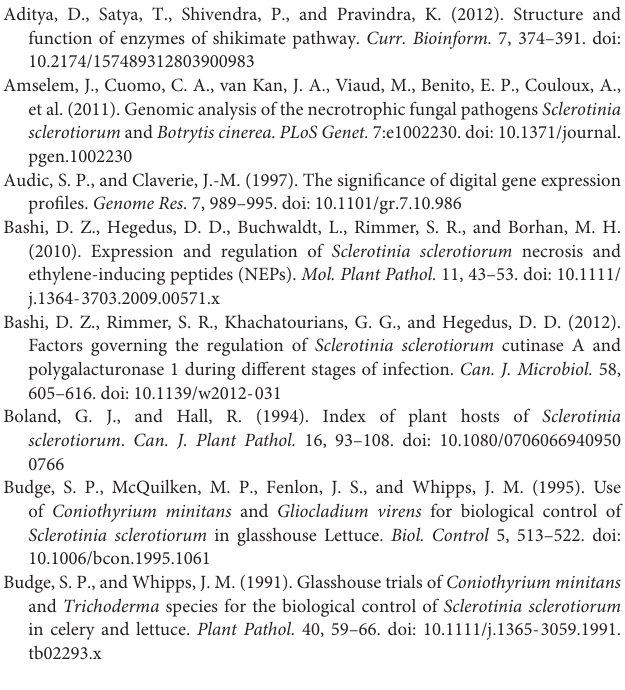
classification database of the fungi species of S. sclerotiorum . TABLE S5 | The secretory proteins in S. sclerotiroum and the related DEGs in S. sclerotiorum induced by C. minitans . TABLE S6 | Gene list of the unclassified DEGs in S. sclerotiorum induced by C. minitans . TABLE S7 | Primers involved this